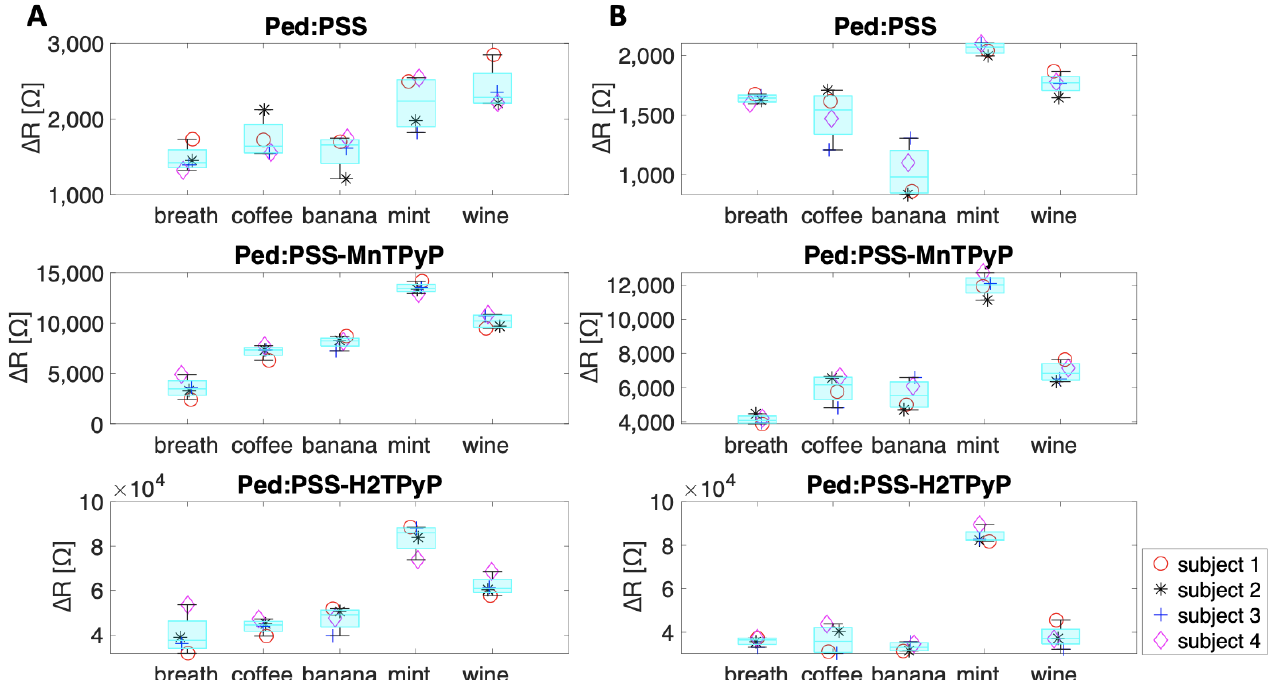
Figure 8. Distribution of the responses of sensors to the basic breath and the ingested foods. ( A ) low frequency breath, ( B ) normal frequency breath. The response of each subject is indicated by a different marker. The class labelled as breath indicates the basic breath before the ingestion of food.